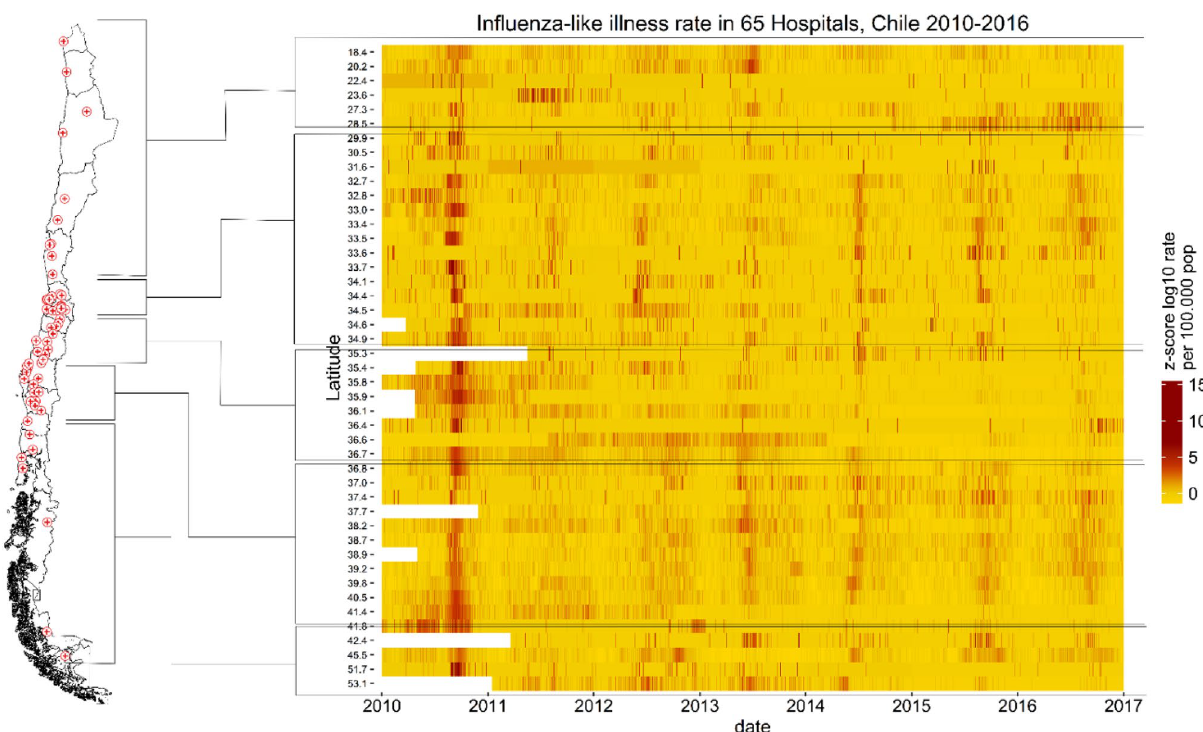
Figure 1. Hospital location and ILI rates, Chile 2010–2016 . Left panel. Location of hospitals included through the Chilean territory. Right panel: Y axis, represent Hospitals ordered by latitude corresponding to the grouped zones marked by horizontal lines. X axis, time in days from 2010 to 2016. Gradient colors represent rates of ILI per 100,000 population. Z-score of log10 transformed shown for better visualization 24,27